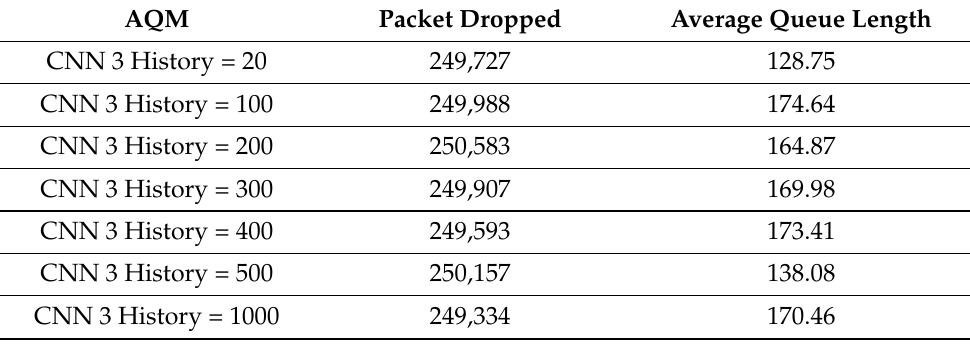
Table 14. Detailed results of queue occupancy results obtained for CNN model trained using data regarding three PI α controllers and H = 0.5.